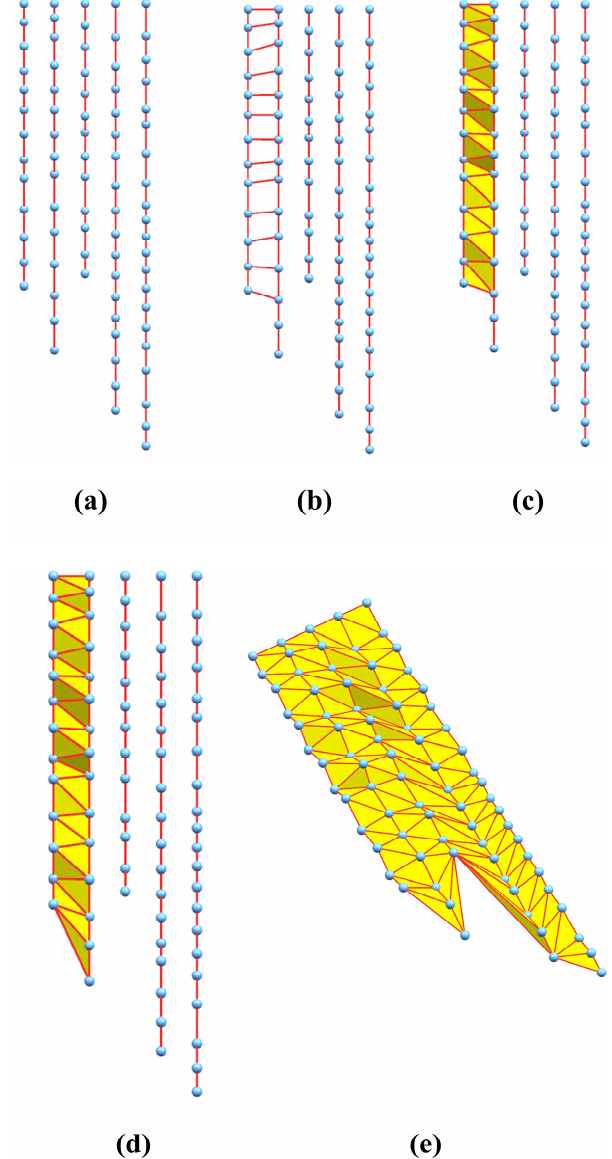
Figure 11. The schematized flow of the triangulation algorithm of 3D point-cloud. ( a ) Concatenate each point-cloud profile with lines; ( b ) Constructe the quadrilaterals; ( c ) Form the triangle-meshes; ( d ) Finish the triangulation of the adjacent point-cloud profiles; ( e ) Complete the triangulation algorithm for the PCM.